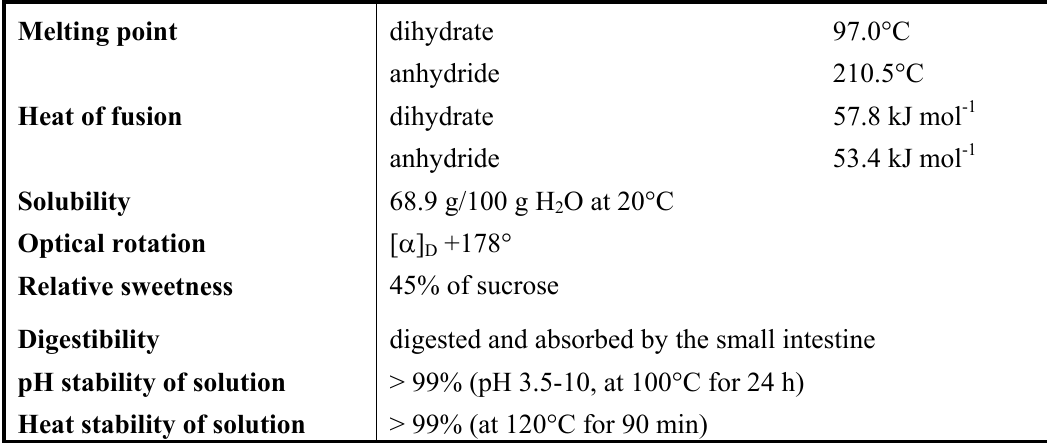
Table 1. Properties of α,α -trehalose (reproduced courtesy of IUPAC and Hayashibara Biochemical Laboratories